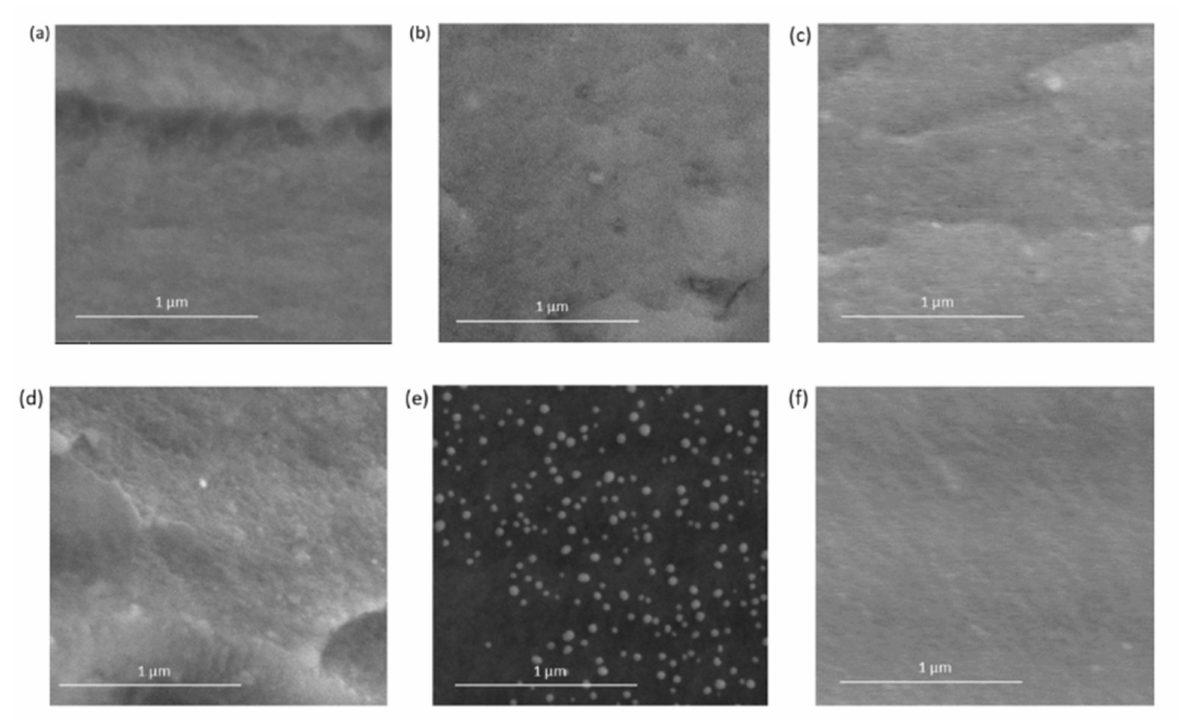
Figure 1. SEM images of silver catalysts: ( a ) Ag/CZ, ( b ) Ag+K/CZ, and the bimetallic systems: ( c ) AuAg+K/CZ, ( d ) AuAg+2K/CZ, ( e ) AuAg+K(+T)/CZ, ( f ) Au reference at the magnification of 100,000